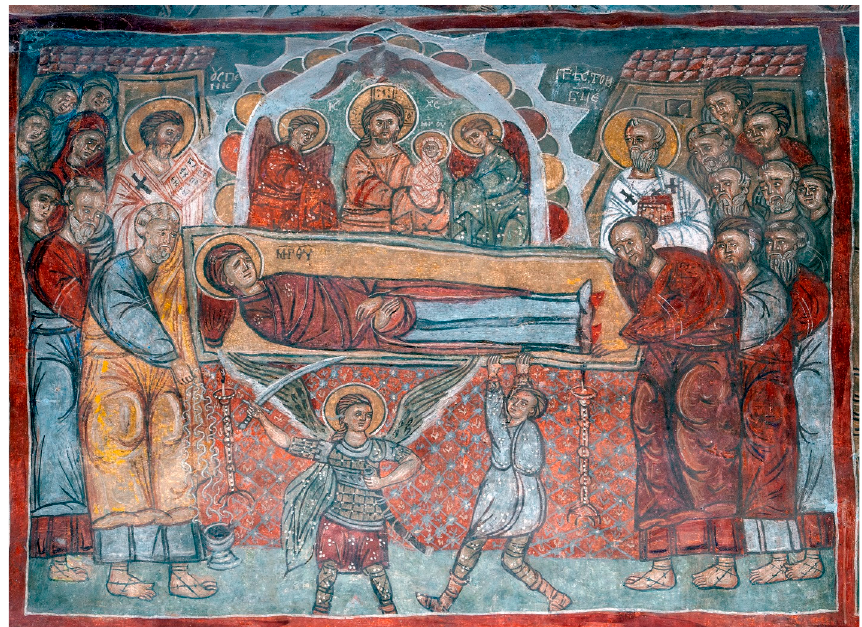
Figure 10. Dormition of the Theotokos , wall painting, 1488, The Church of St. Demetrius, Boboshevo, Bulgaria. (Photo credit: Angel Yordanov, TerraByzantica ).